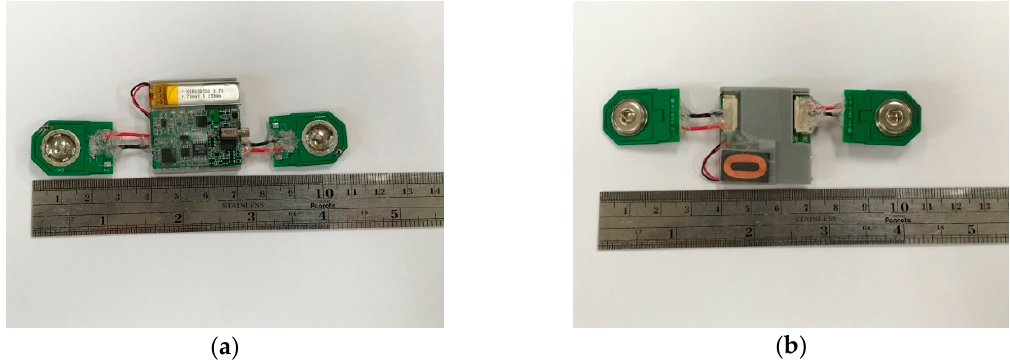
Figure 4. Two views of the EMG patch, ( a ) top view; ( b ) bottom view.